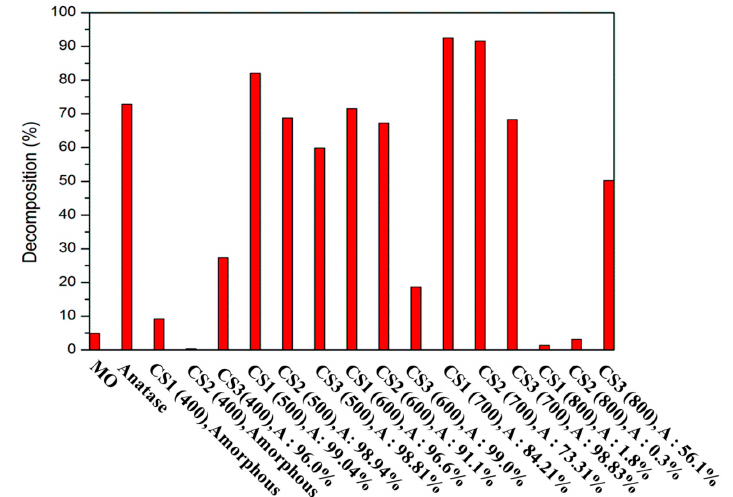
Figure 11. MO decomposition comparison of different calcination temperatures and phase composition of synthesized hollow particles.